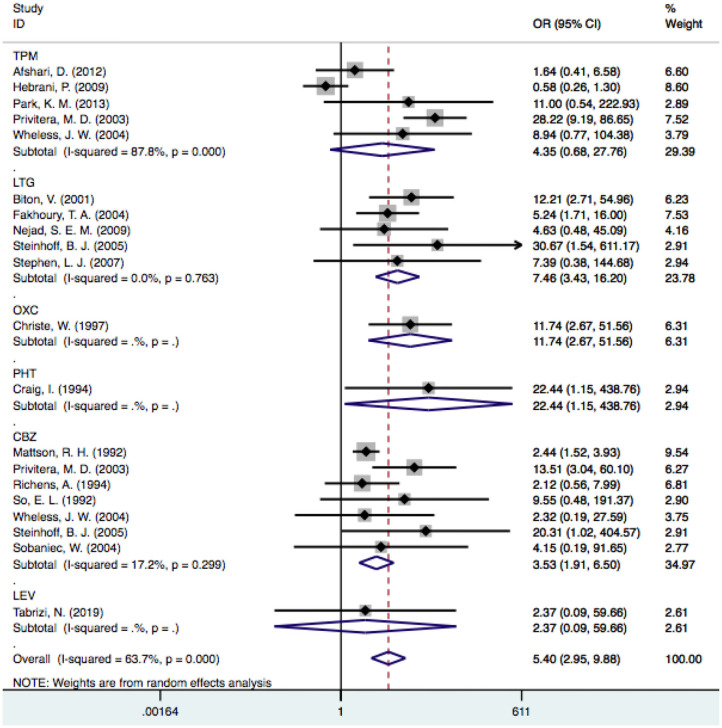
The pooled OR of VPA-associated tremor with other AEDs respectively. VPA, valproic acid; AEDs, antiepileptic drugs; TPM, topiramate; LTG, Lamotrigine; OXC, oxcarbazepine; PHT, phenytoin; CBZ, carbamazepine; LEV, levetiracetam.